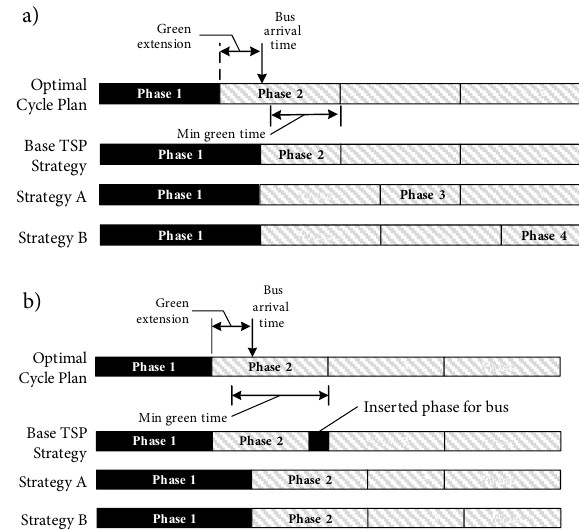
Fig. 1. Signal timing plans under different TSP strategies: a – compressible time of Phase 2 is larger than the green extension time; b – compressible time of Phase 2 is smaller than the green extension